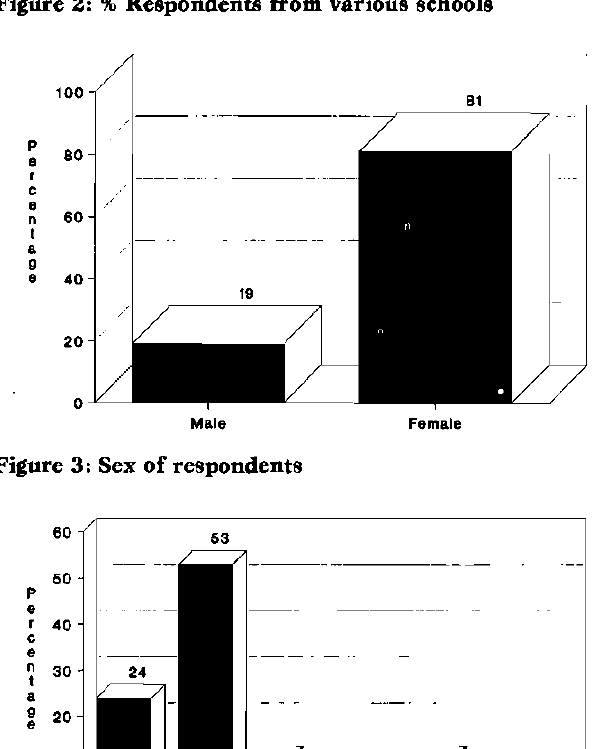
Figure 2: % Respondents from various schools